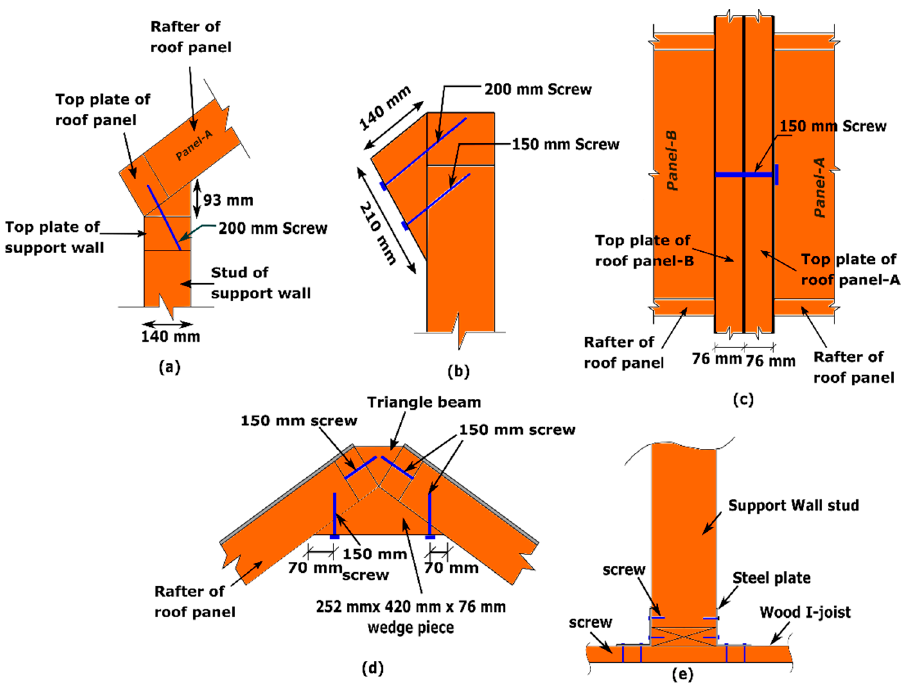
Figure 4. ( a ) Connection-A and Connection-D, ( b ) Connection-B ( c ) Connection-C, ( d ) Connection-E, ( e ) Connection-F.